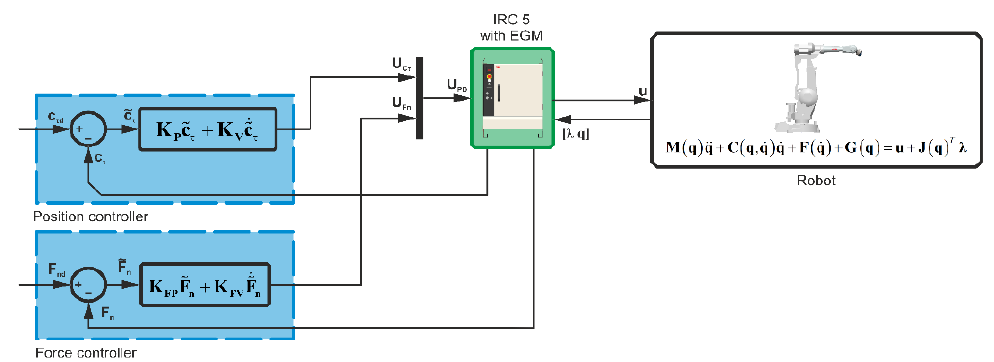
Figure 7. Diagram of the position–force control system for the ABB IRB 2400